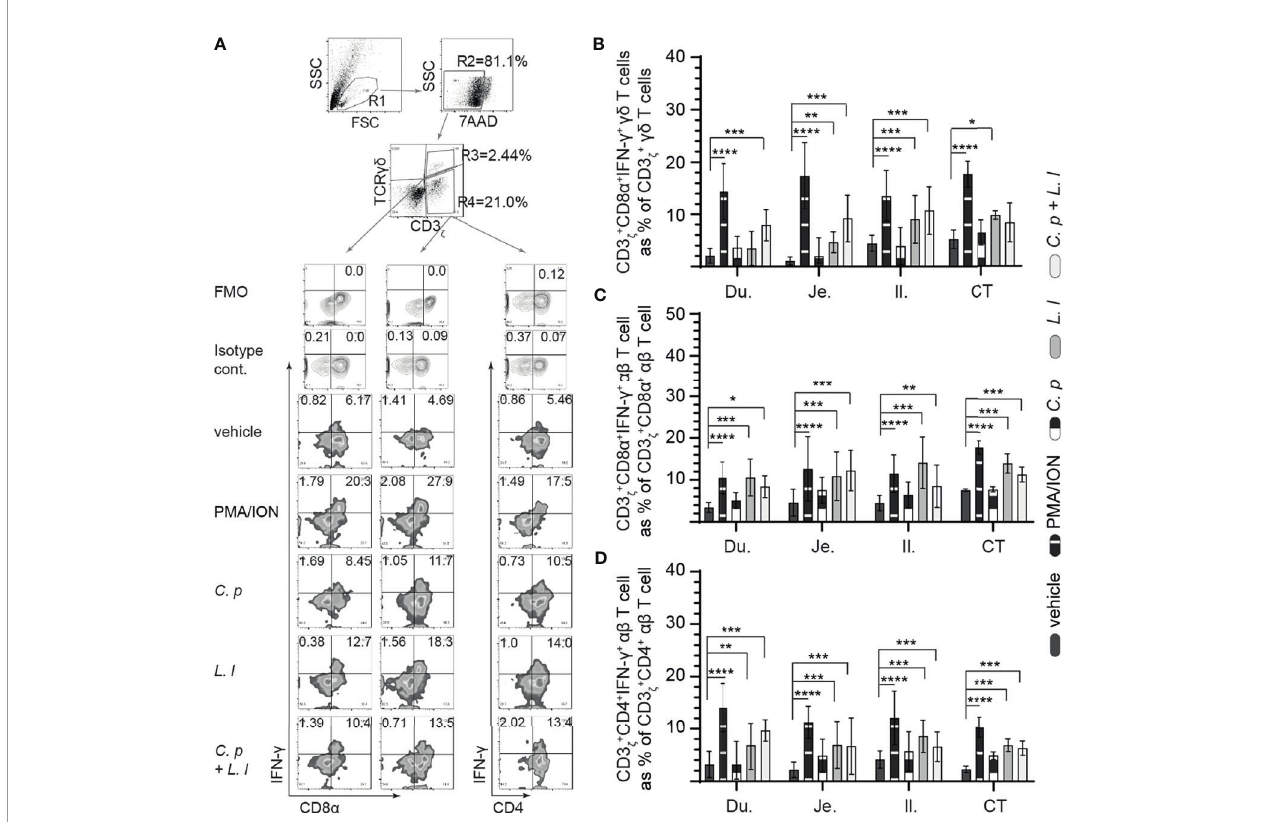
FIGURE 4 | Ex vivo L. lactis treatment elicited intracellular IFN g expression in intestinal mononuclear cells. Small intestine mononuclear cells ( n = 6) were isolated from the duodenum, jejunum, ileum, and cecal tonsils. Cells were stimulated with medium alone (vehicle), PMA (50 ng/ml) plus ION (1 m g/ml), C perfringens (1 MOI), L. lactis (MOI = 1), and combination of C perfringens (MOI = 1) and L. lactis (MOI = 1). Cells were harvested at 18 h poststimulation, and data were analyzed for frequency of IFN g + cells using fl ow cytometry. (A) Dot plots and density plot demonstrating the gating strategy utilized to de fi ne the frequency of (B) CD3 z +CD8 a +IFN g + gd T cells, (C) CD3 z +CD8 a +IFN g + ab T cells, and (D) CD3 z +CD4+IFN g + ab T cells. Paired t -test was used to assess normal distribution and test signi fi cance. * p < 0.05, ** p < 0.001, *** p < 0.0005, and **** p < 0.0001 indicate a statistically signi fi cant difference. The mean ± SD value are shown from